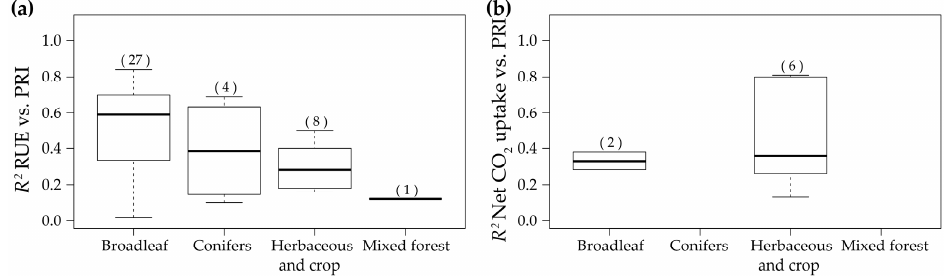
Figure 8. Boxplots of the coefficients of determination of the relationships between PRI and ( a ) Radiation-use efficiency (RUE) and ( b ) Net CO 2 uptake at the ecosystemic level and seasonal timescale. Central lines represent medians, boxes represent 50% of the data and whiskers represent minima and maxima. The numbers of correlations reported in the literature are shown in brackets.